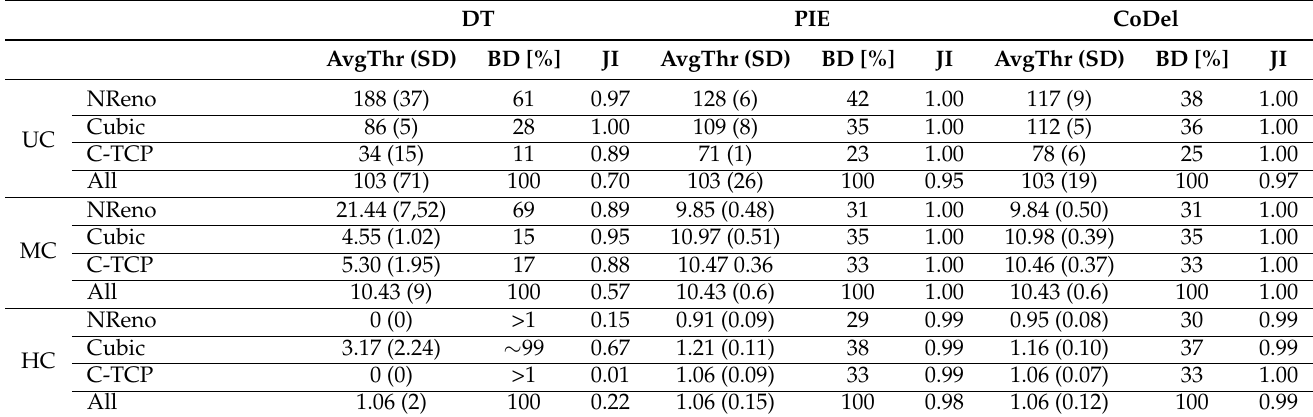
Table 10. The summary results in the data center scenario with mixed TCPs, UC—uncongested, MC—mildly congested, HC—heavily congested network.